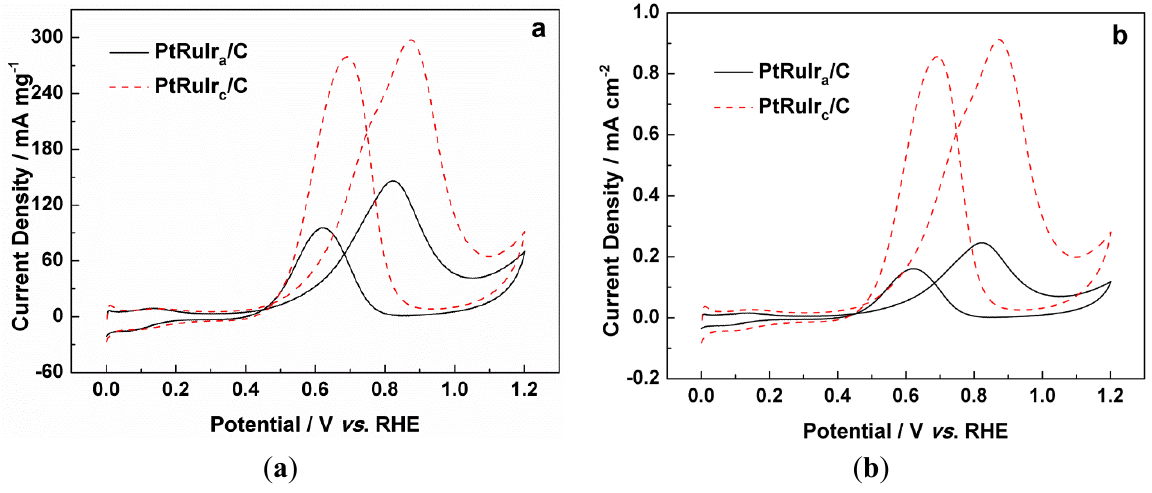
Figure 5. Cyclic voltammograms of PtRuIr metal loading on the electrodes ( a ) and ECSA H SO solution under N 2 4